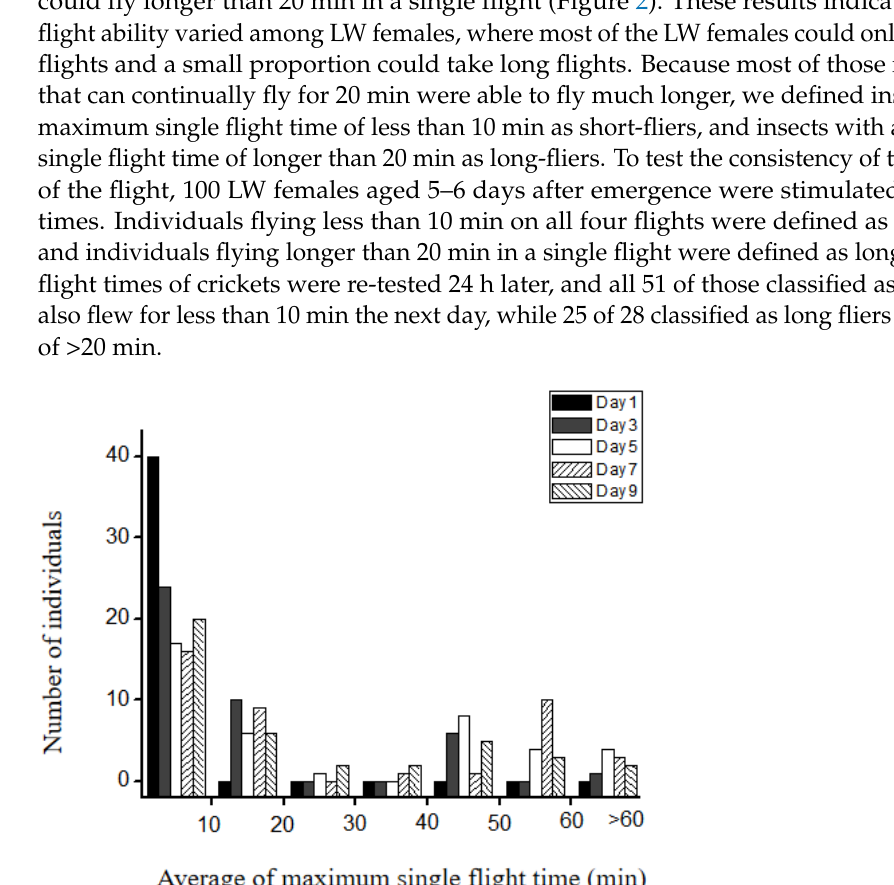
Figure 1. Effect of age on the mean total flight time of LW females of V. asperses stimulated to fly in a 4 h period. Different letters indicate a significant difference between groups by post hoc multiple comparisons of the means, p < 0.05, n = 40 for each group.